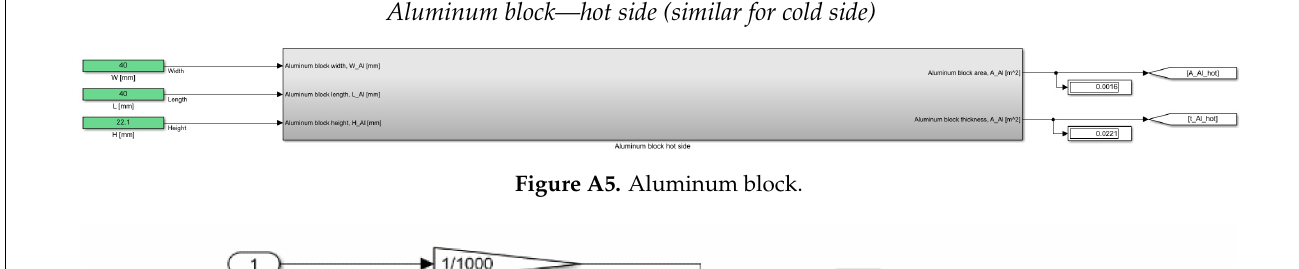
Figure A4. Hot side heat exchanger block—HX pressure drop equations and outputs. Aluminum block—hot side (similar for cold side)